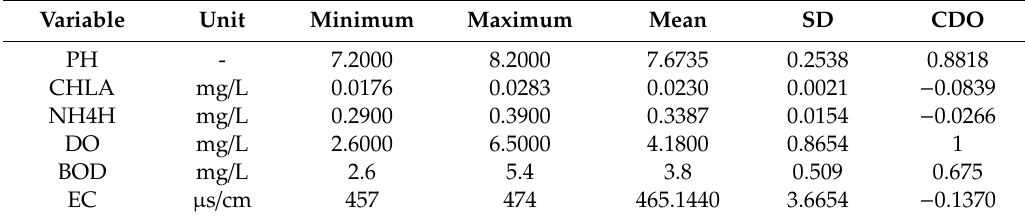
Table 1. Basic statistics of the measured water quality variables of Beihai Lake. 92